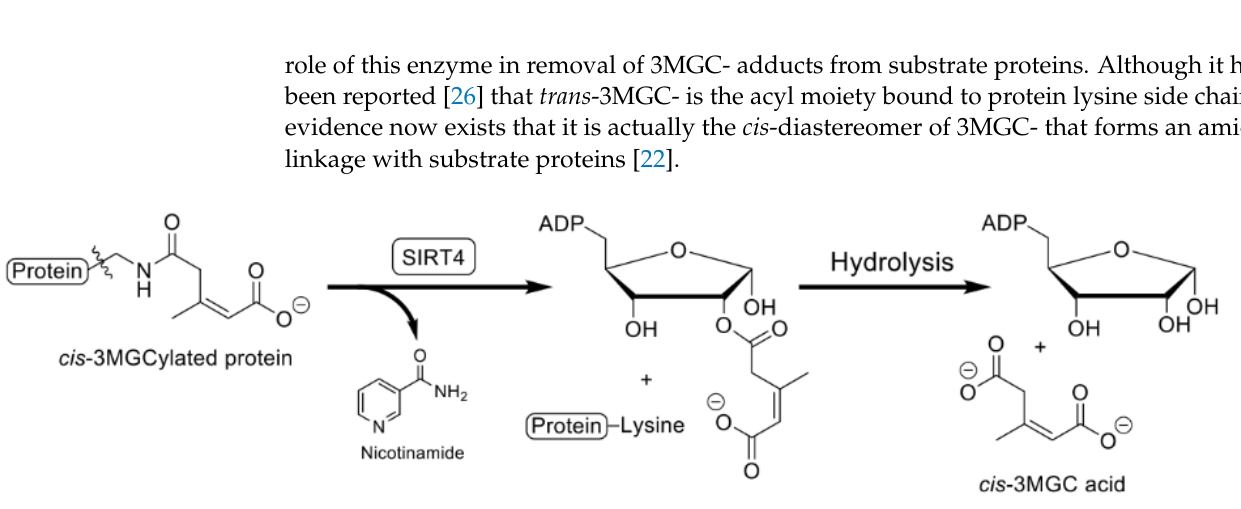
Figure 5. SIRT4-mediated deacylation of 3MGCylated proteins. As 3MGCylated proteins are gen- Figure 5. SIRT4 ‐ mediated deacylation of 3MGCylated proteins . As 3MGCylated proteins are gener ‐ erated via the non-enzymatic phase of the acetyl CoA diversion pathway, they become substrates ated via the non ‐ enzymatic phase of the acetyl CoA diversion pathway, they become substrates for for SIRT4 deacylase activity. This reaction, which employs NAD + as a co-substrate, initially yields SIRT4 deacylase activity. This reaction, which employs NAD + as a co ‐ substrate, initially yields nic ‐ nicotinamide and 2- O - cis -3MGC ADP ribose as products. Subsequent non-enzymatic hydrolysis of otinamide and 2 ‐ O ‐ cis ‐ 3MGC ADP ribose as products. Subsequent non ‐ enzymatic hydrolysis of 2 ‐ 2- O - cis -3MGC ADP ribose yields the products, ADP ribose and cis -3MGC O ‐ cis ‐ 3MGC ADP ribose yields the products, ADP ribose and cis ‐ 3MGC acid.